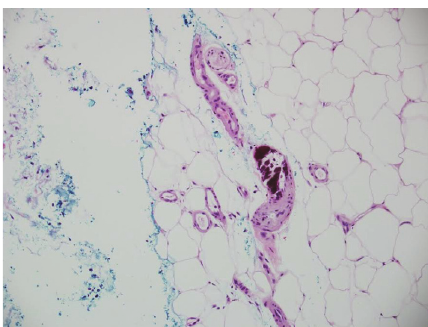
Figure 2: Biopsy left calf, illustrating arteriolar calcification in subcutis.